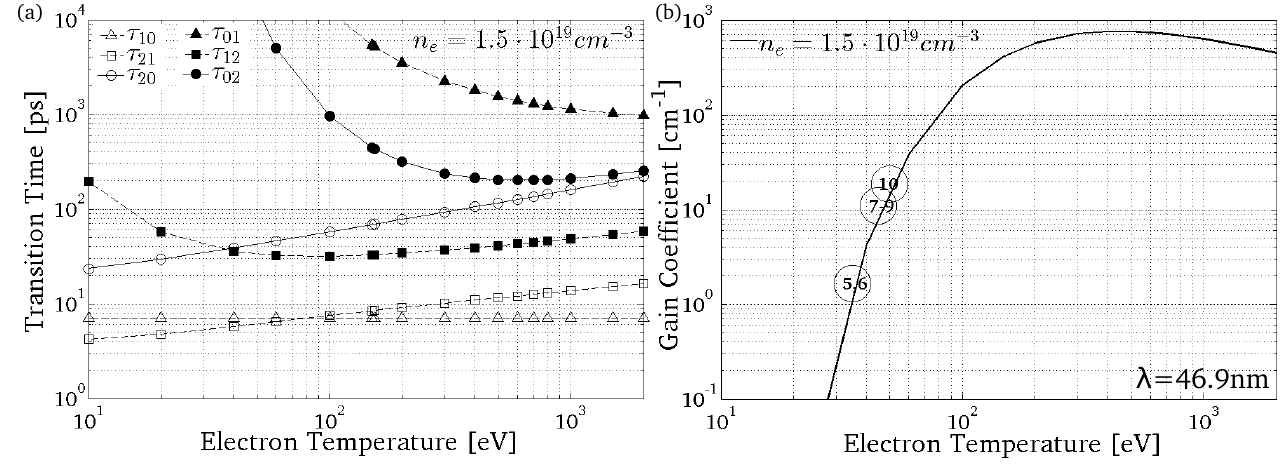
( a ) Transition time (Equation (3)) between Ne-like Ar +8 levels (Figure 1) at the optimum electron density of 1 . 5 · 10 19 cm − 3 [30] as a function of temperature. ( b ) Gain coefficient of the Ne-like Ar +8 laser at a wavelength λ = 46 . 9 nm. Benchmarking data [5–10] from the literature (numbered circles) from experiments for gain coefficients of Ne-like Ar +8 laser-produced plasma are